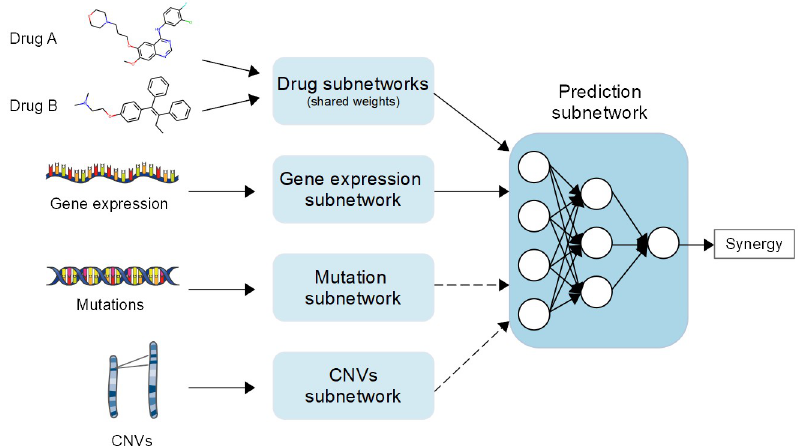
Fig 1. A representation of the general architecture of the multimodal DL models developed in this study. A model is defined as a combination of the learning algorithm itself and the data preparation steps required